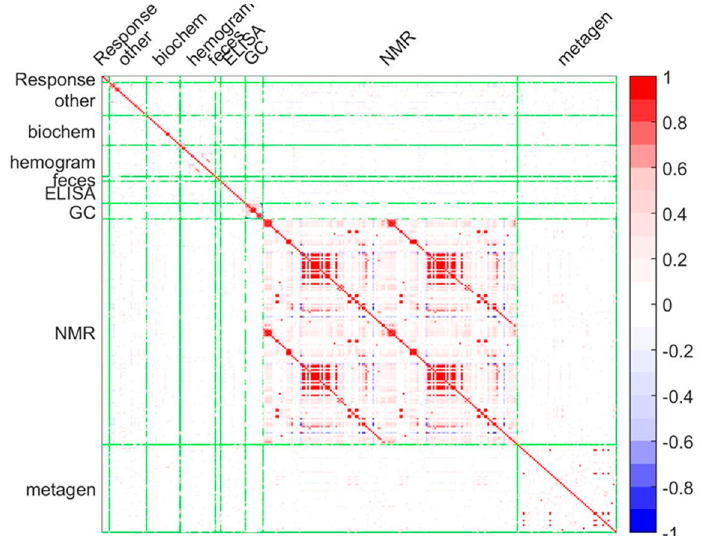
Figure 2. Multivariate Exploratory Data Analysis (MEDA) correlation map. MEDA technique of the predictive correlations was performed [41]. Green lines represent the divisions between the response and the di ff erent datasets. Biochem: Biochemical data; Hemogram: hemogram data; Feces: Lactic D and L acid; NMR: nuclear magnetic resonance data (noesy and cpmg data); GC: gas-chromatography short-chain fatty acids data; Metagen: metagenomics data; ELISA: Elisa and luminex data.